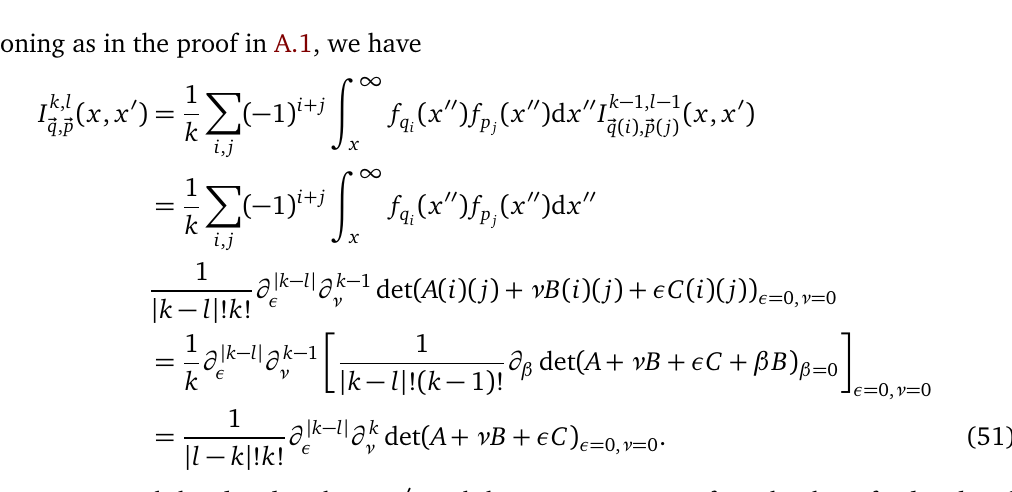
Figure 10: Integrated difference square of the position space density for the ground (cid:113) m = 1 for the 2 + 1 system compared with the matrix product states state at g ħ h 3 ω